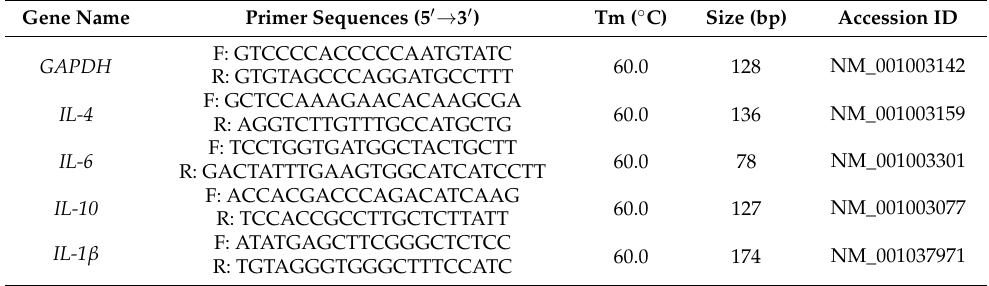
Table 1. The primers of mRNAs for